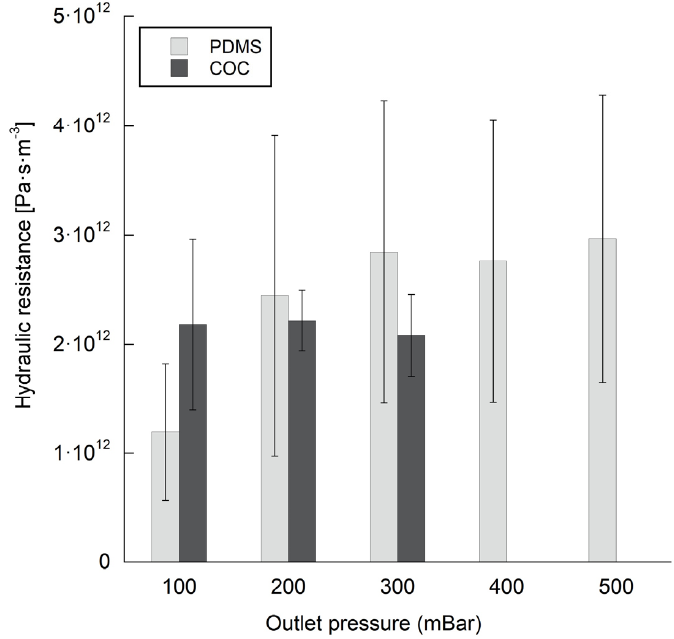
Figure 4. Hydraulic resistance for PDMS and COC Biochips.